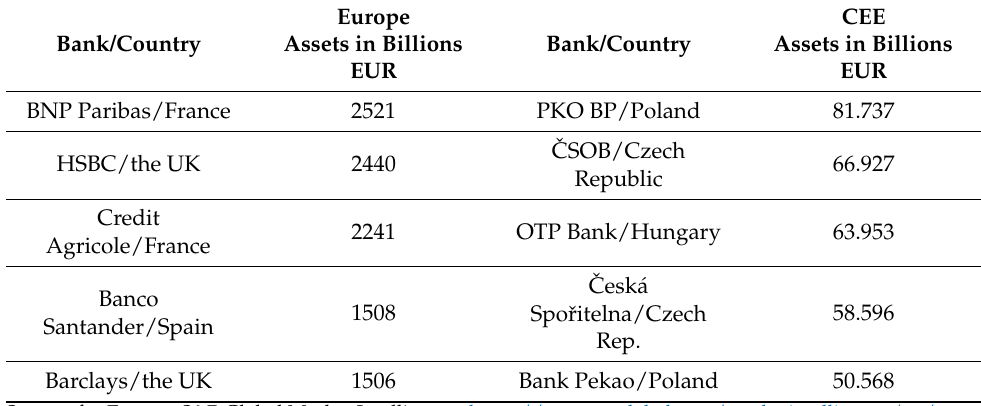
Table 1. Leading banks by assets in Europe and CEE (excluding Russia), December 2020.